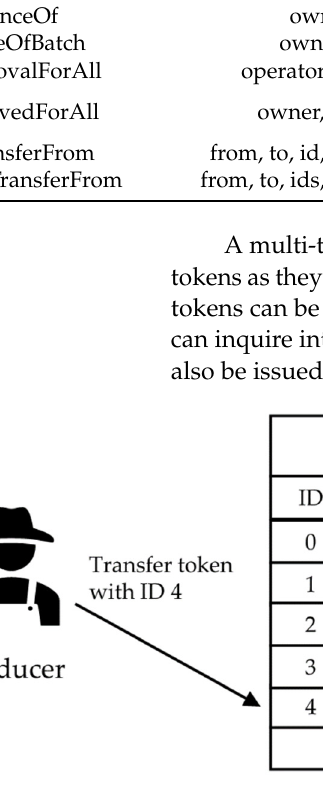
Table 4. Ethereum Multi-token standard ERC-1155 interface function list.